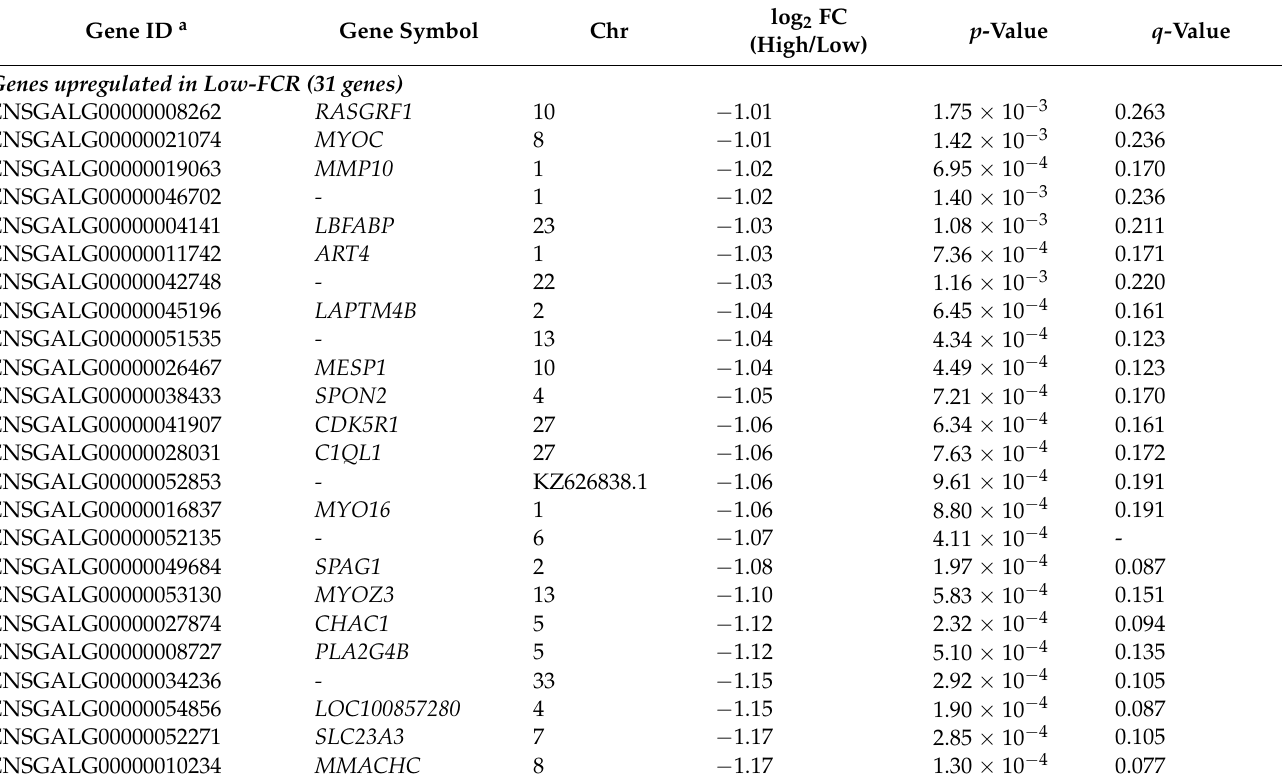
Figure 3. Volcano plot of the 24,356 transcripts quantified in the jejunum from KR chickens with differences in FCR. The horizontal lines indicate the significant thresholds of DEGs at p -value < 0.01. The vertical line corresponds to the threshold of |log 2 FC| > 1. Red dots represent the significant DEGs at p -value < 0.01 and |log 2 FC| > 1 . Table 3. Genes differentially expressed ( p < 0.01; |log 2 FC| > 1) in the jejunum of KR chickens with differences in feed conversion